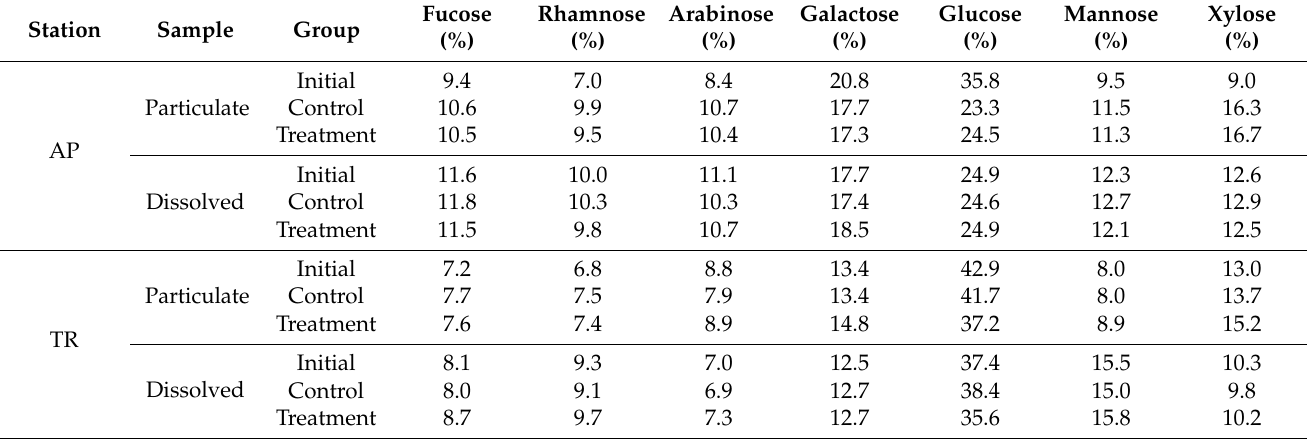
Table 3. Mol fraction of neutral aldose. Abbreviations: AP: coastal Avery Point site; TR: estuarine Thames River site. Initial denotes the field data; treatment denotes samples after two days of rolling; and control denotes samples incubated for two days without rolling. Each sample had